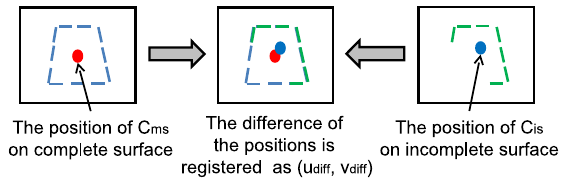
Figure 5: Position difference among templates